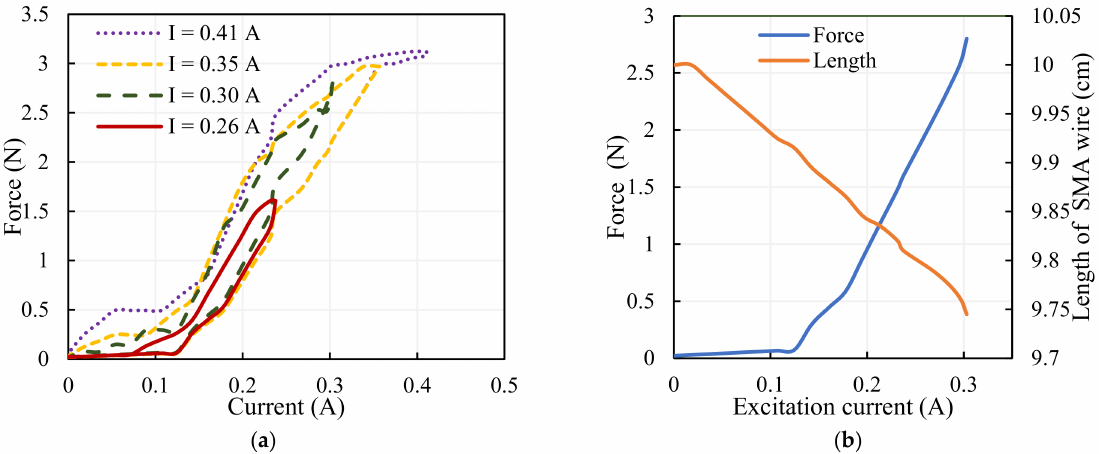
Figure 6. SMA characteristics: ( a ) identification of actuation current, ( b ) correlation between current;